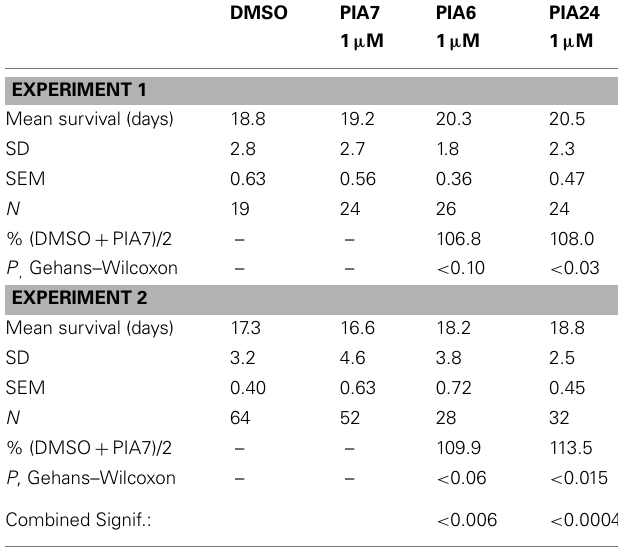
Table 2 | Effects of PIAs on wild-type (N2) lifespan at